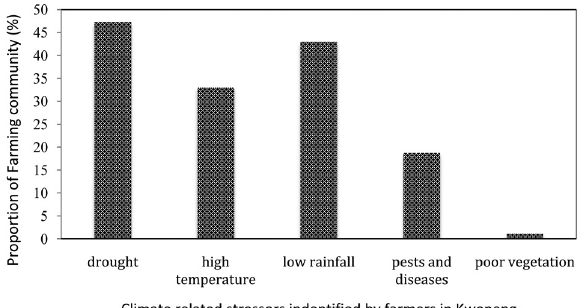
Adaptive strategy Frequency (%) Crop sector Change of planting